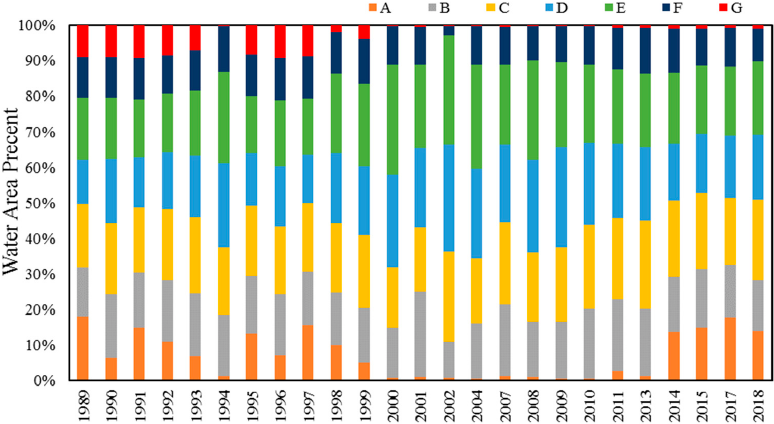
Figure 14. Each subregion as a percentage of the total area. For reference, the percentage of A refers